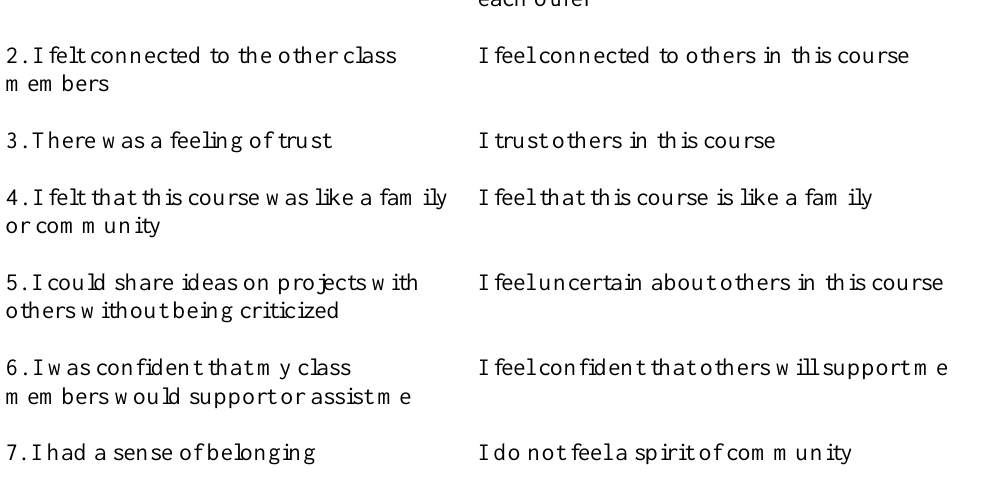
Adapted and Original Connectedness Subscale Comparison Adapted Connectedness Subscale Original Connectedness